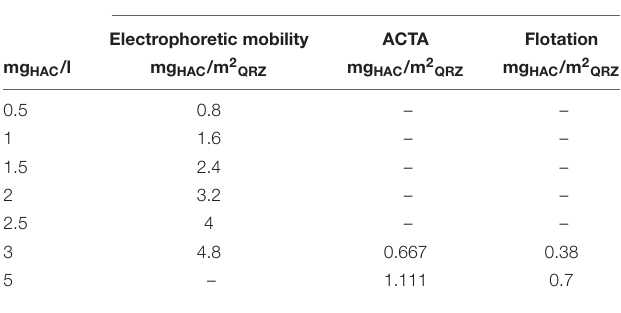
TABLE 2 | The used HAC concentrations in mass of HAC related to the volume of the aqueous suspension for the electrophoretic mobility tests, ACTA experiments and their equivalents displayed as mass of HAC related to the surface area of